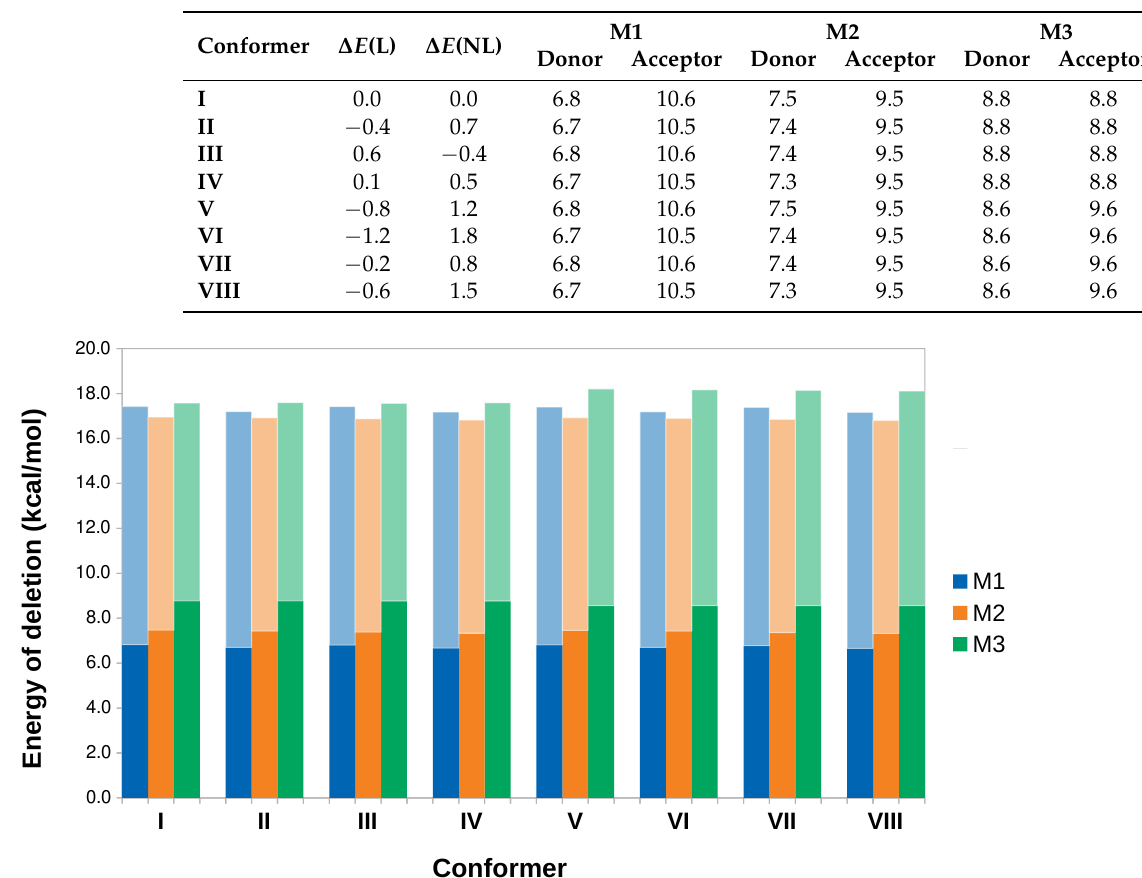
Figure 4. Hyperconjugation contributions to the conformations of the methyl groups in caffeine (M1, M2, M3 in Figure 2). Dark rectangles correspond to deletions of the NL orbitals involved only in charge donation from the methyl groups, light boxes account for the energy associated when deleting NL orbitals in the methyl groups when those groups act as charge